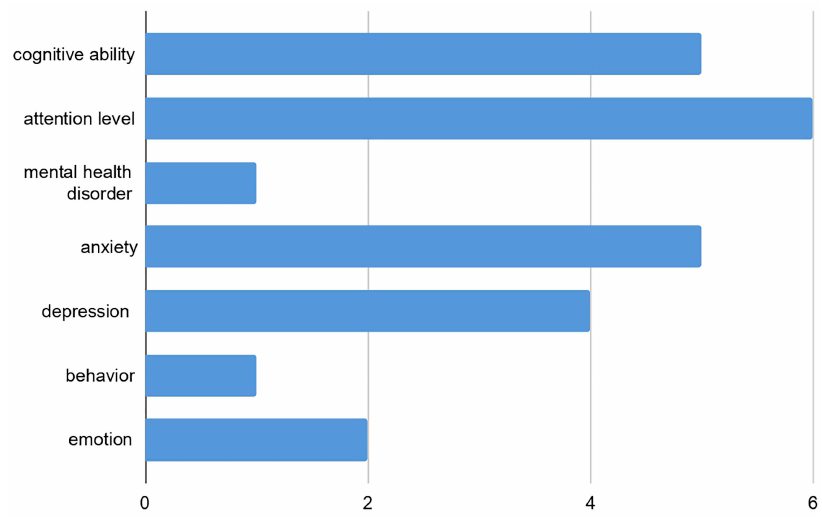
Figure 6. Categories of Children’s Restorative Outcome Measurements.